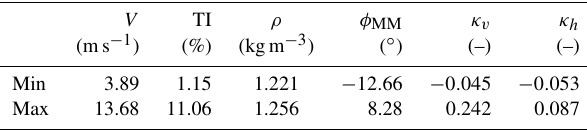
Table 1. Minimum and maximum values of rotor effective wind speed, turbulence intensity (TI), density, yaw misalignment, and vertical and horizontal shear within the training